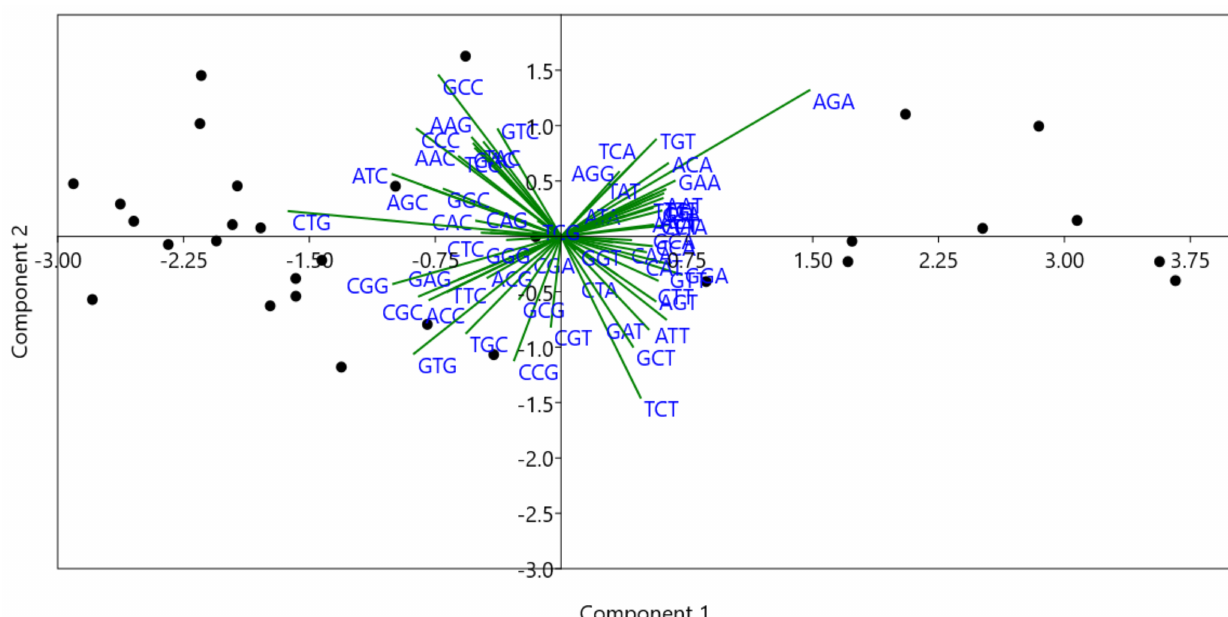
Figure 9. Biplot analysis showing CTG and AGA codons are most influential across axis 1. The length of the arrow is proportional to the influence of the codon on codon usage bias.